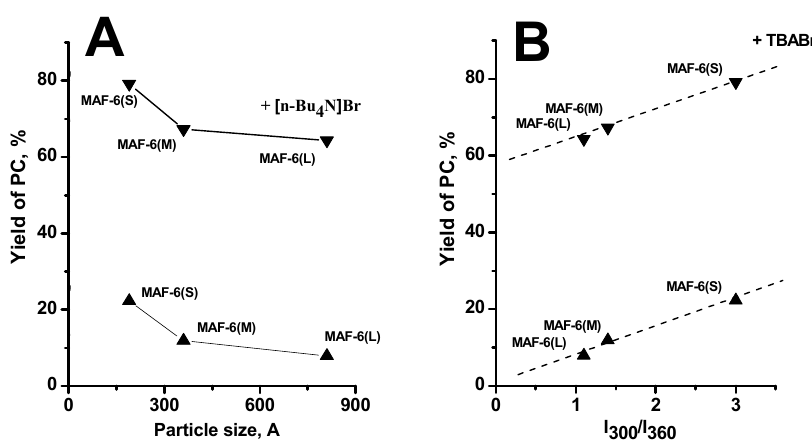
Figure 6. Dependence of PC yield on particle size of MAF-6 ( A ) and the number of Lewis acidic sites (I 300 /I 360 ) ( B ).